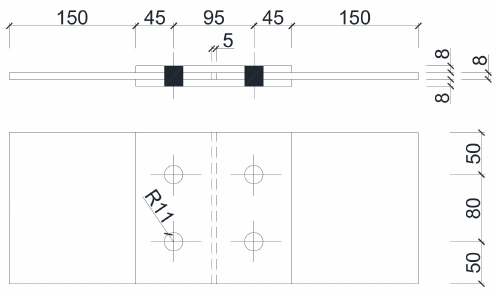
Figure 1. High-strength bolts connection (TX series).